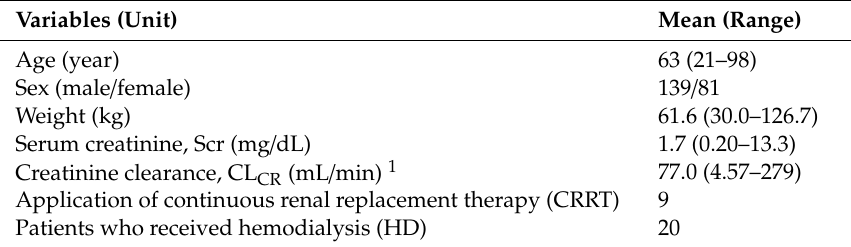
Table 1. Demographic and clinical characteristics of